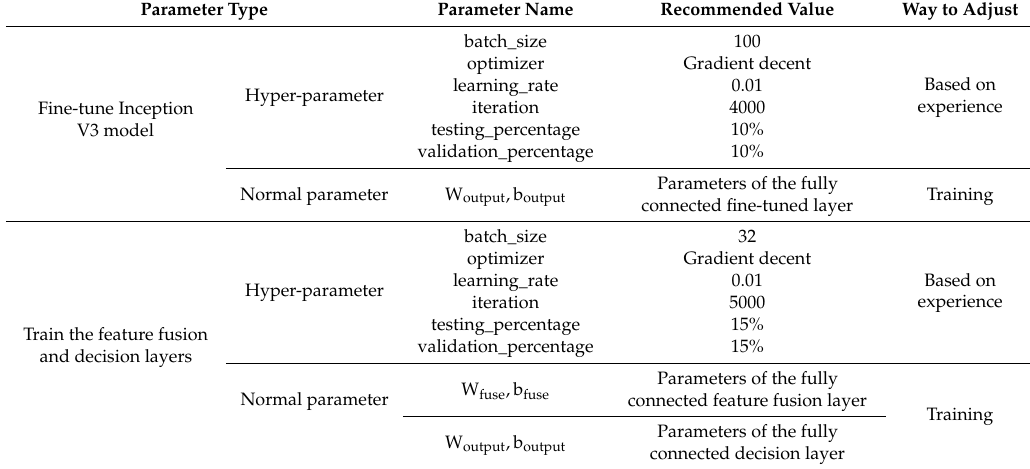
Table 1. Main parameters set in the training